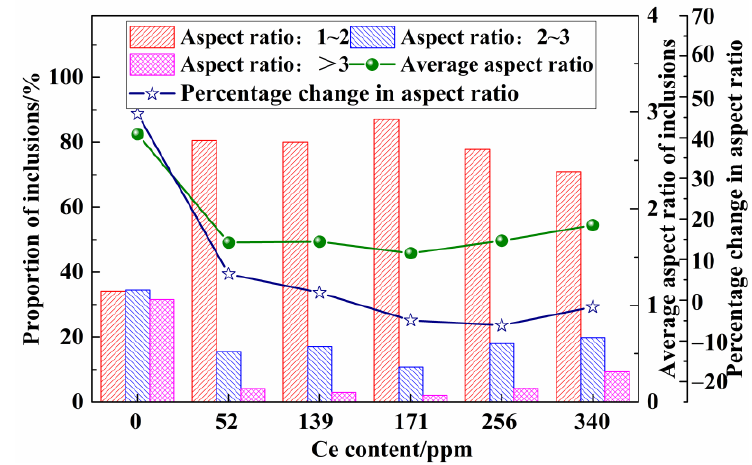
Figure 11. Aspect ratio of inclusions after simulated